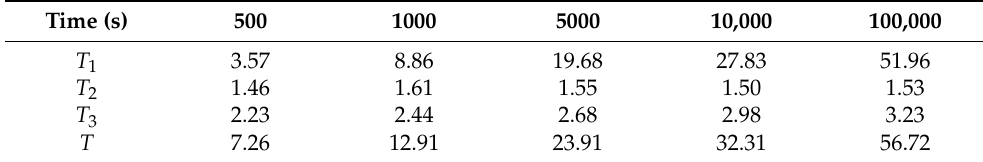
Table 6. Timetable Required for Network Attack Recovery.